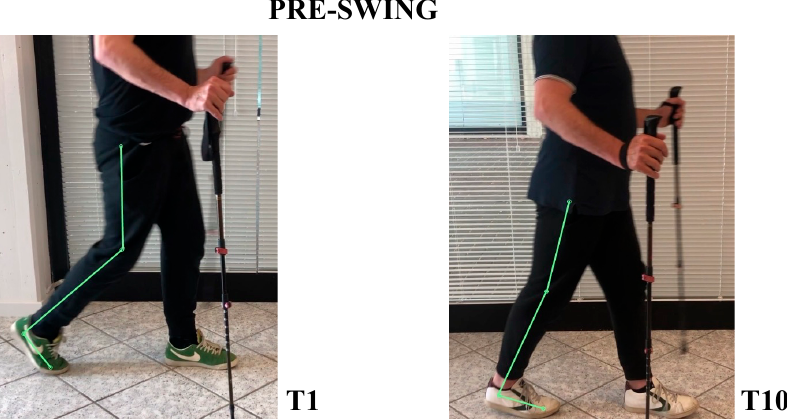
Figure 6. Mid-stance frames at initial ( T1 ) and final ( T10 ) evaluation; with RAGT training, the patient gained the ability to extend the loading knee and hip, allowing the swinging limb a more dynamic and less wasteful flexing movement.